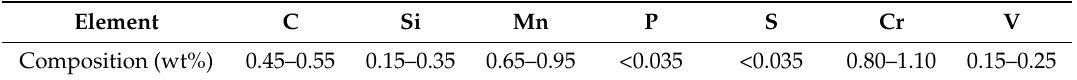
Table 1. Chemical composition of SUP-10